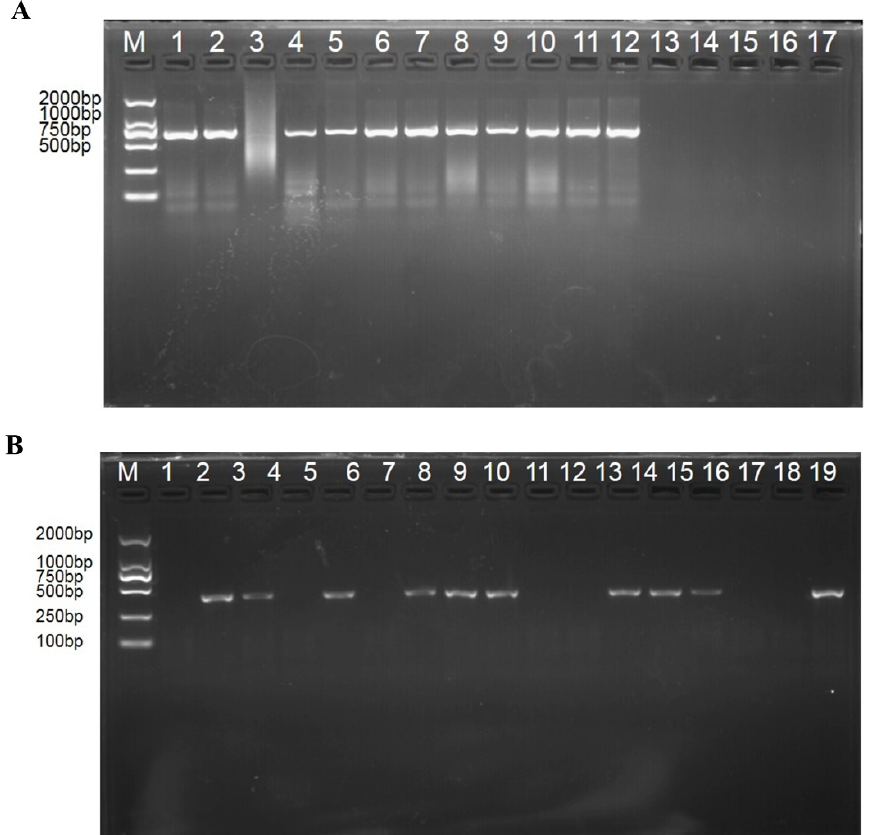
Figure 1. Molecular characterization of T. controversa and T. foetida . ( A ) Molecular detection of T. foetida from the inoculated plants. Lane 1: the positive control; lane 2–12: plants inoculated with T. foetida ; lane 13: ddH 2 O; Lane 14–17: healthy wheat tissue. ( B ) Molecular detection of T. controversa from the inoculated plants. Lane 1: ddH 2 O; lane 2–18: plants inoculated with T. controversa ; lane 19: positive control. M indicates the molecular marker DL2000.